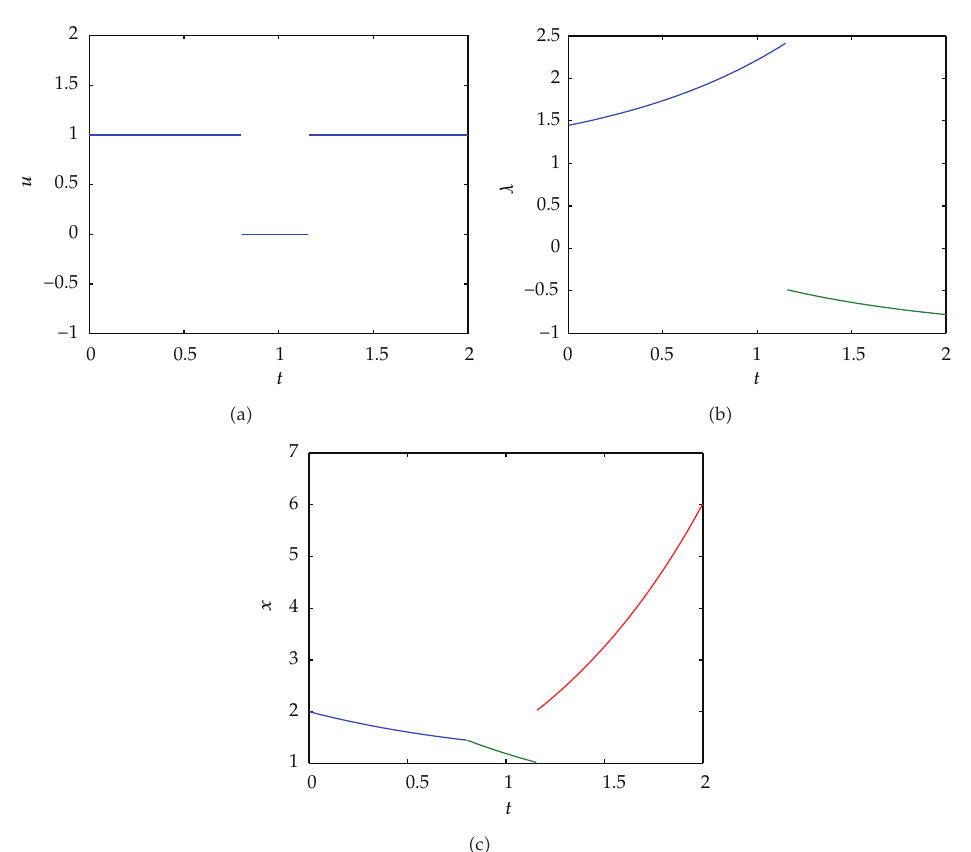
Figure 1: Control, adjoint, and state variable in the Example